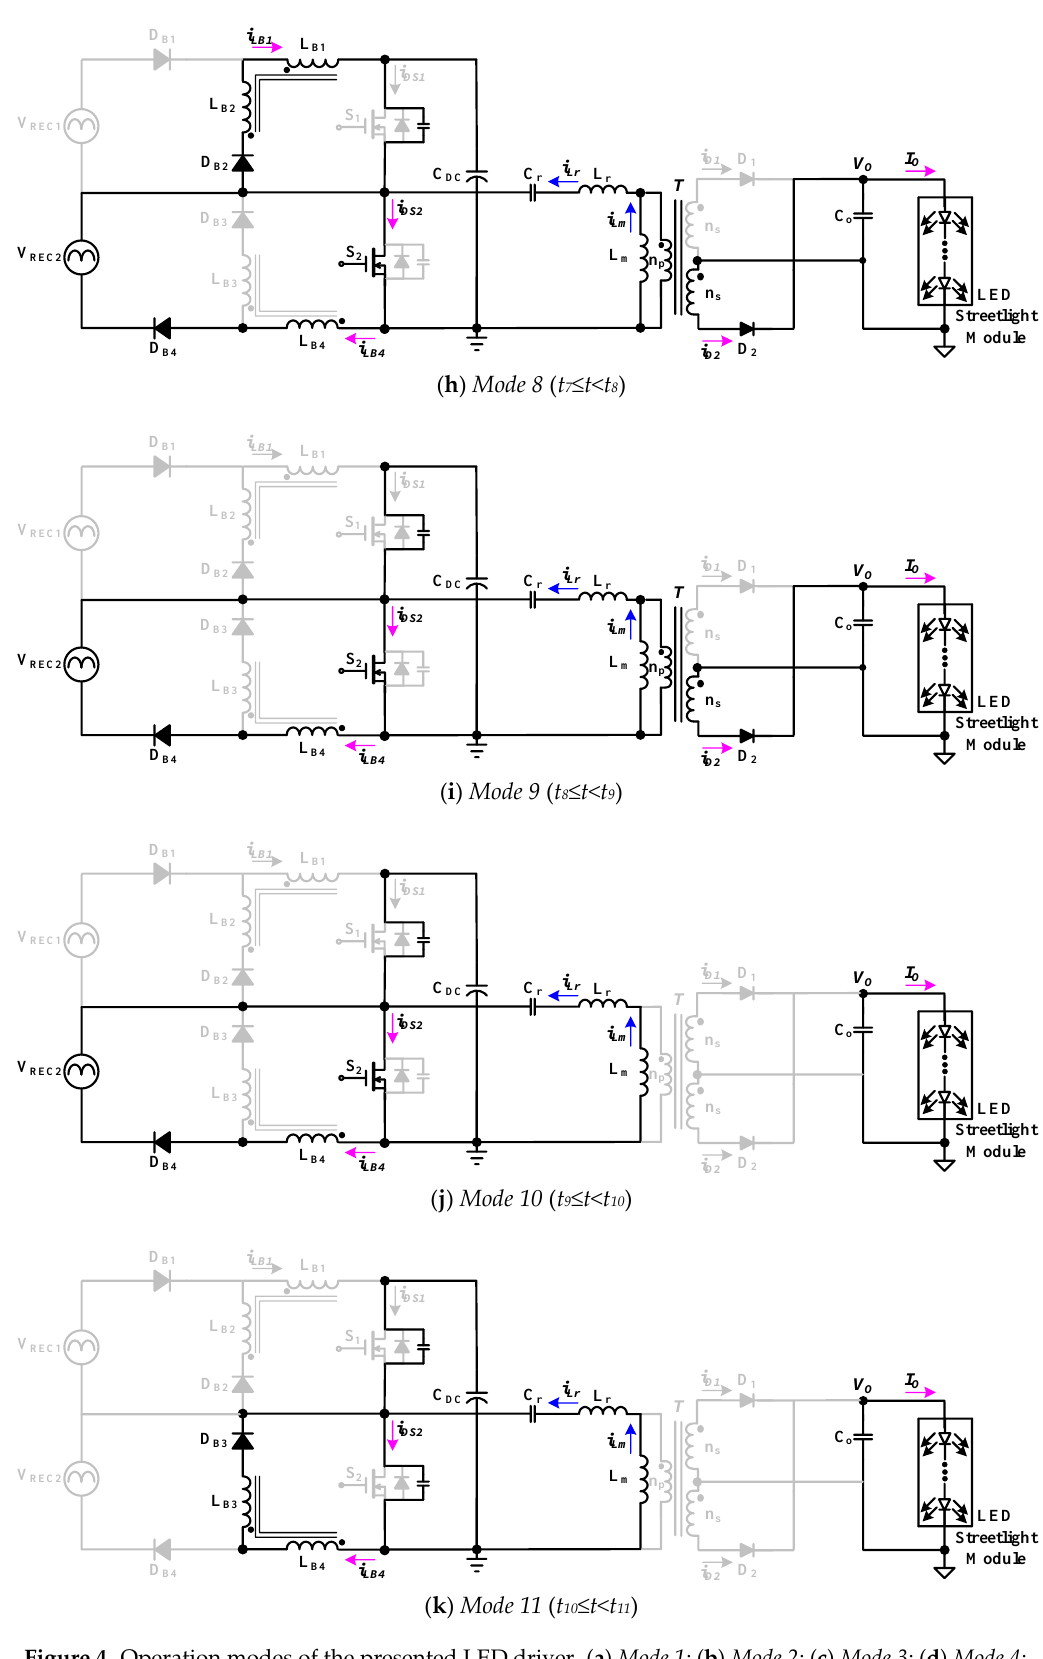
Figure 4. Operation modes of the presented LED driver. ( a ) Mode 1 ; ( b ) Mode 2 ; ( c ) Mode 3 ; ( d ) Mode 4 ; ( e ) Mode 5 ; ( f ) Mode 6 ; ( g ) Mode 7 ; ( h ) Mode 8 ; ( i ) Mode 9 ; ( j ) Mode 10 ; ( k ) Mode 11.